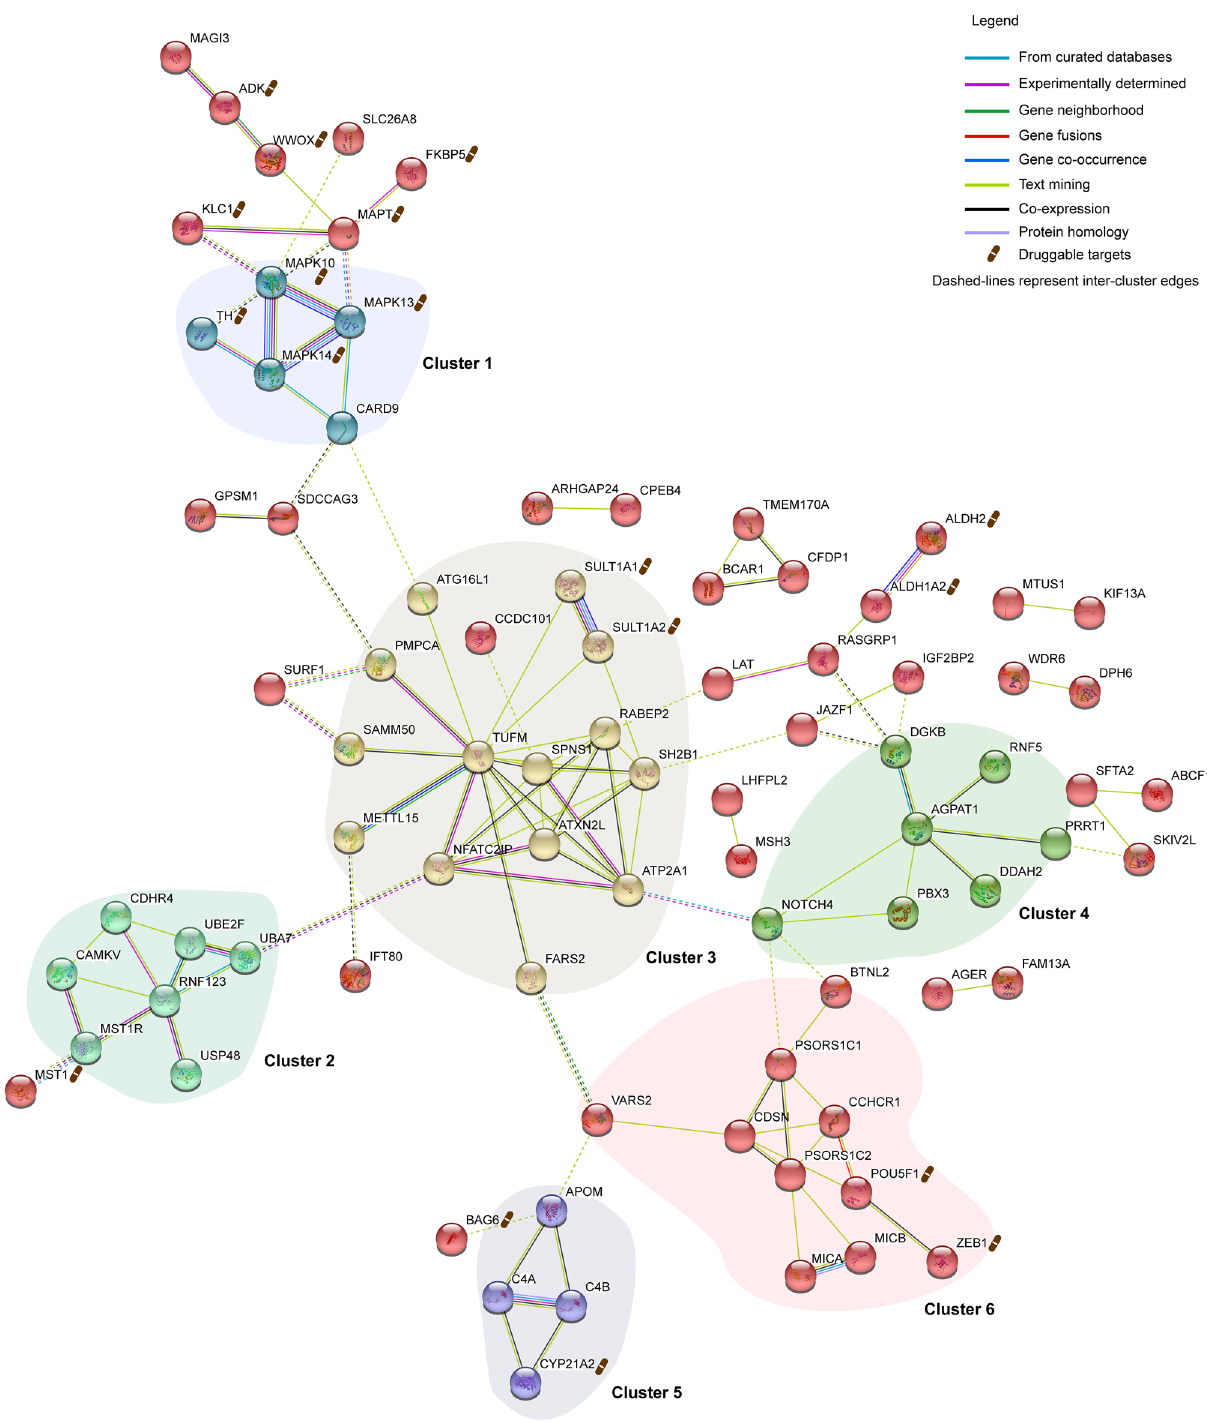
Figure 6. Protein–protein interaction network identifies existing drug targets that may impact diabetes. A protein–protein interaction network for the pleiotropic genes was constructed using string-db-org (http:// string- db. org; version 11 53 ) set to a medium confidence of 0.400 and prediction methods (i.e. genomic context prediction channels—neighbourhood, fusion, and co-occurrence; together with co-expression, text mining, curated databases, and experiments). 137 nodes (i.e. genes encoding functional proteins) were identified from an input of 165 genes at a PPI enrichment of p < 1.0 × 10 –16 . Nodes with at least 2 interactions are shown. PPI clusters were identified using K-means clustering algorithm set to 6 clusters (K-means = 6). Dashed lines represent inter-cluster edges. Proteins with a drug symbols are targets for existing FDA-approved drugs from the Drug Gene Interaction database (DGIdb; v3.0.2). A summary of the protein interaction network with the respective interaction scores is available in Supplementary Table S14. A summary of the drug-gene interactions from DGIdb is available in Supplementary Table